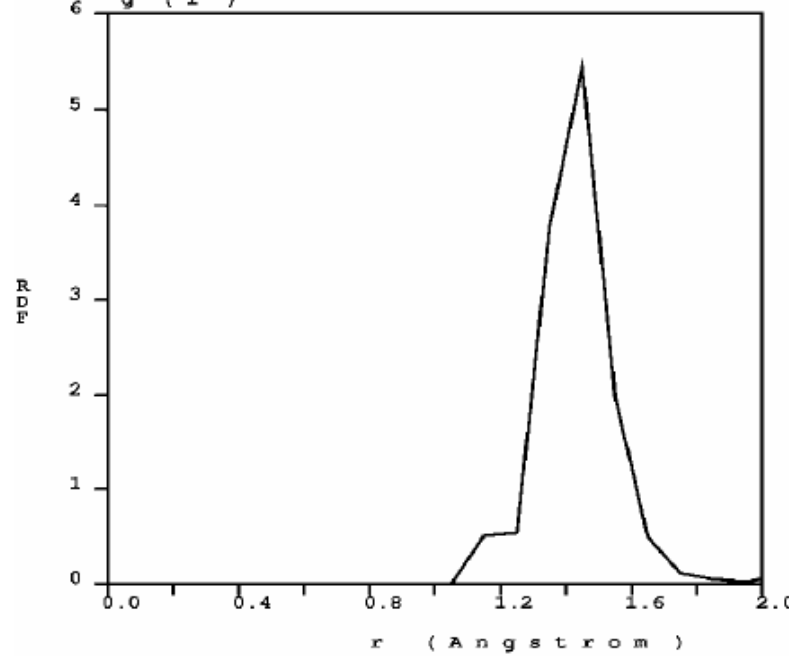
Figure 2. Bonding details of the first peak of the RDF of nanocarbon. There is a structure in the first peak that may be associated to graphitic bonds (1.45 Å), double bonds (1.35 Å) and triple bonds (1.15 Å). The diamond interatomic distance is 1.54